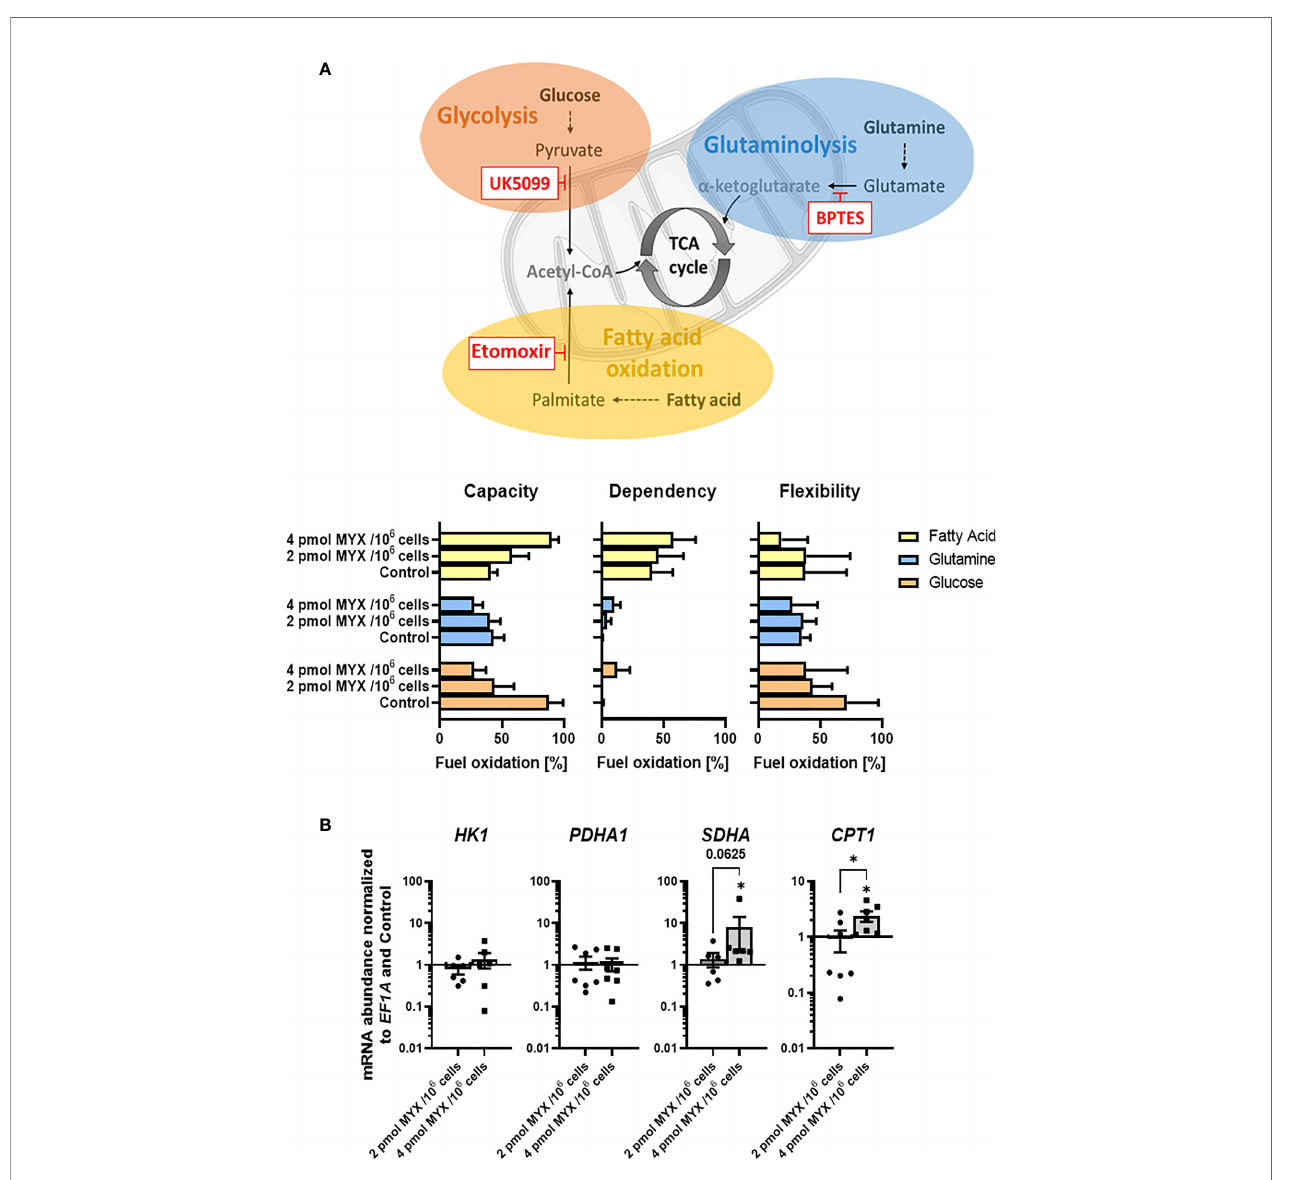
FIGURE 5 | Metabolic restriction increased the capacity and dependency of monocytes for the use of fatty acids but reduced the use of glycolysis. (A) Seahorse XF Mito Fuel Flex Test was performed using 2 µM UK5099, 3 µM BPTES, and 4 µM etomoxir to block glucose oxidation, glutamine oxidation, and fatty acid oxidation, respectively (n = 3). Mitochondrial stress and glycolytic parameters were measured via OCR in pmol/min/1x10 5 cells and are shown as percentage of max values and depicted as bars (mean ± SEM). (B) Gene expression of HK1 , PDHA1 , SDHA , and CPT1 was normalized to the expression of EF1A and to the respective Control (mean ± SEM; n = 6; *p < 0.05; Wilcoxon signed rank